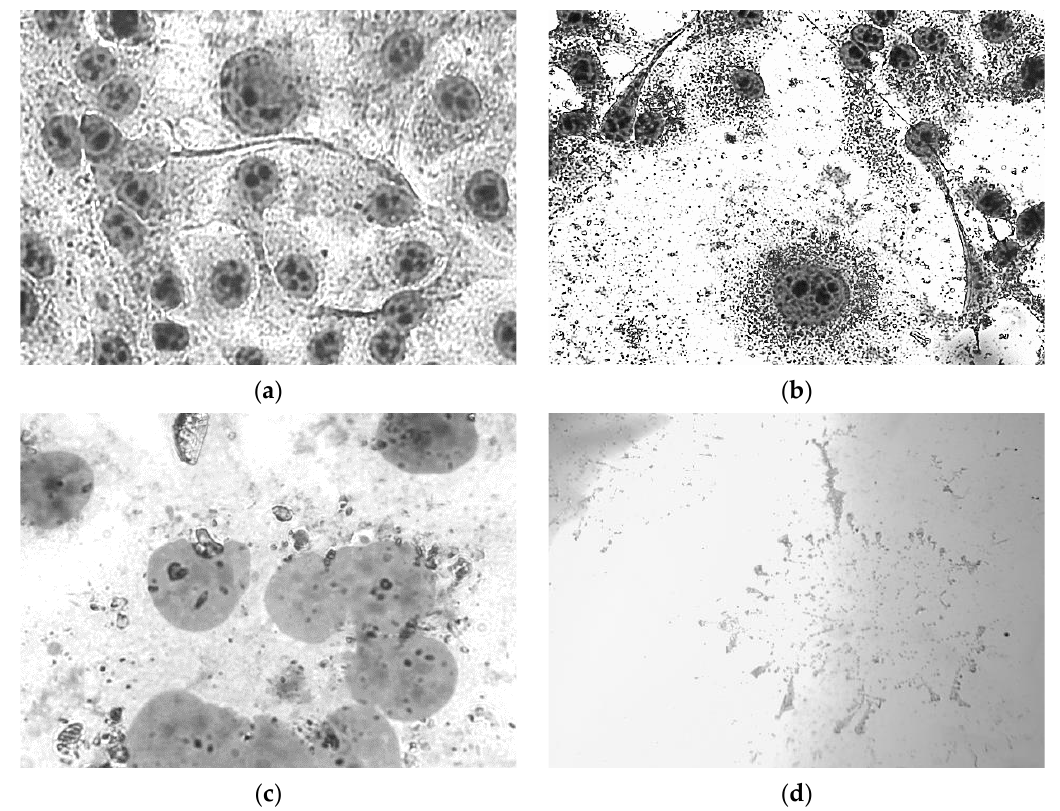
Figure 3. Morphological changes in HeLa cells in 72 h after exposure to pyrazolone derivatives 5b,f, 9a : ( a ) control; ( b ) nuclear pyknosis under compound 9a action; ( c ) nuclear swelling under compound 5b action; ( d ) complete destruction of cell under compound 5f . Romanowsky – Giemsa staining, magnification ×400.